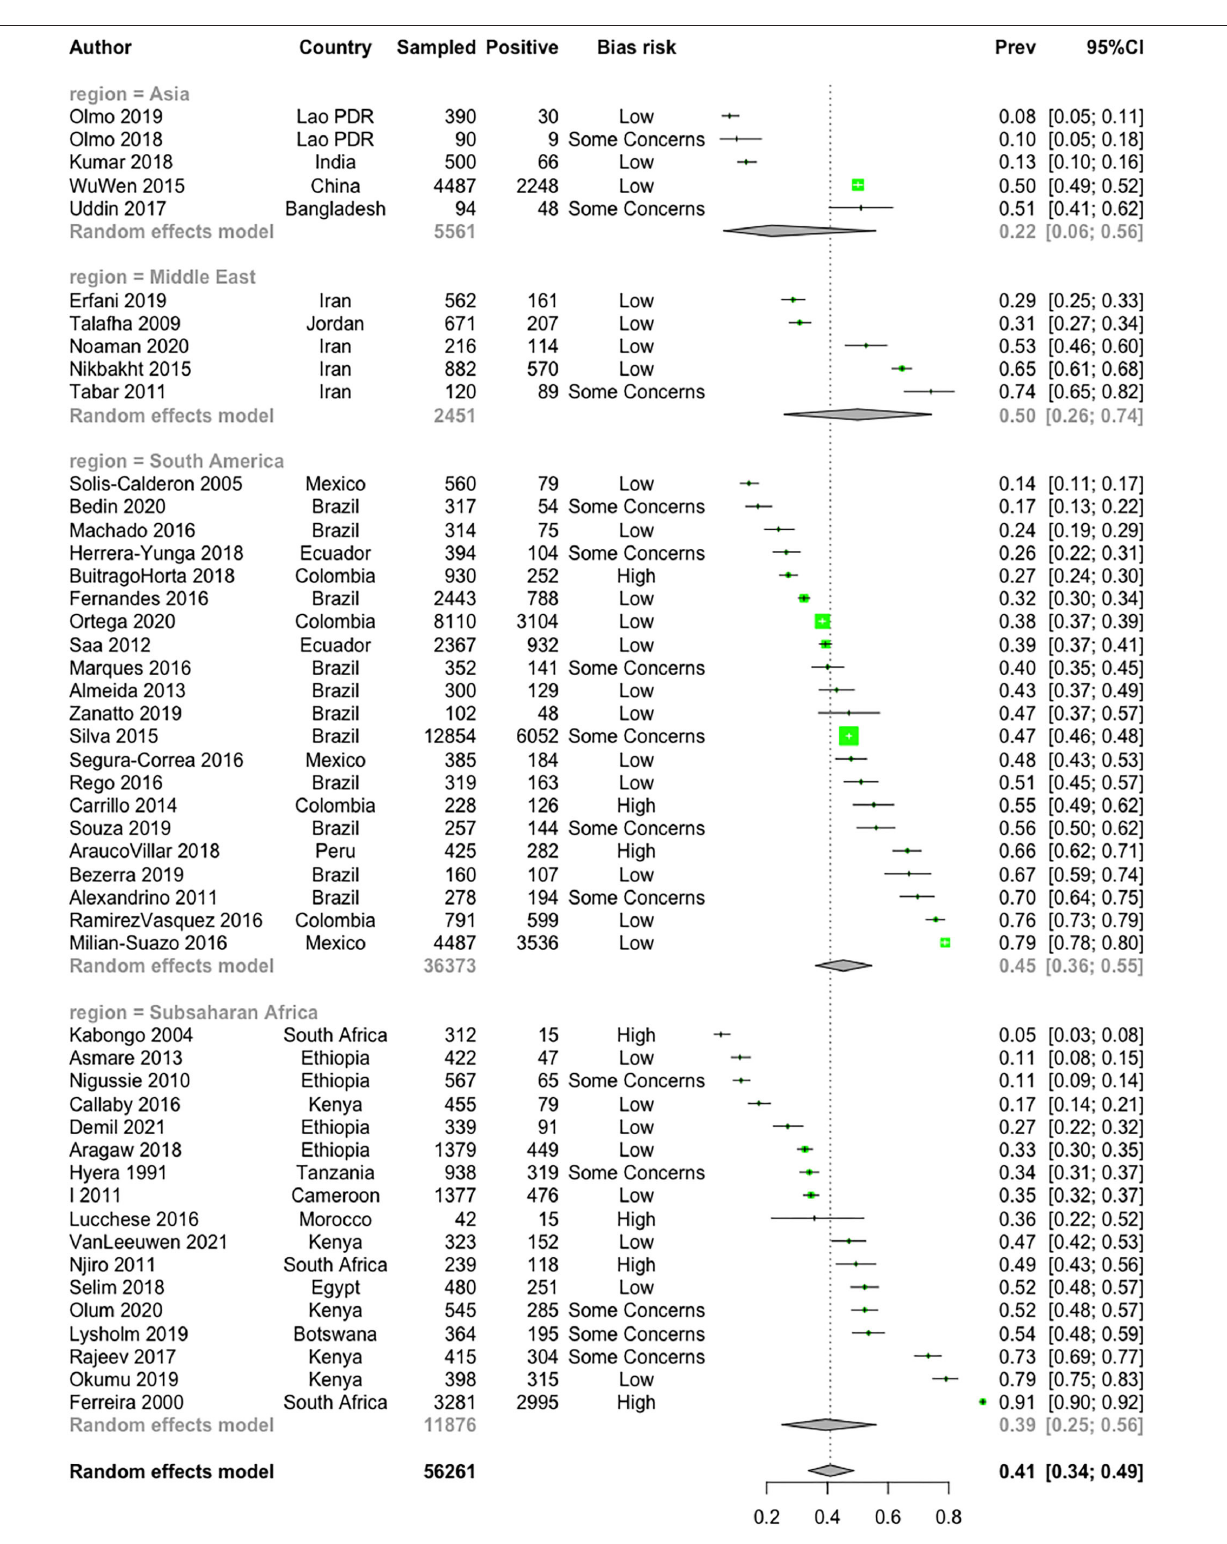
Frontiers in Veterinary Science |